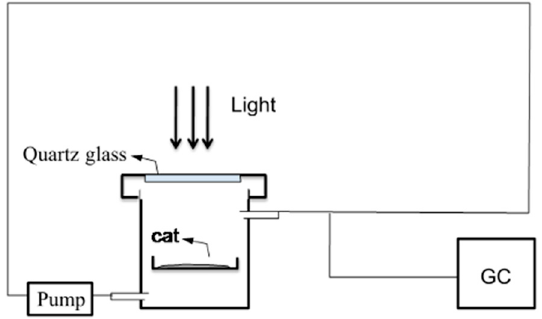
Figure 11. Schematic diagram of photocatalytic gas phase degradation of Toluene.